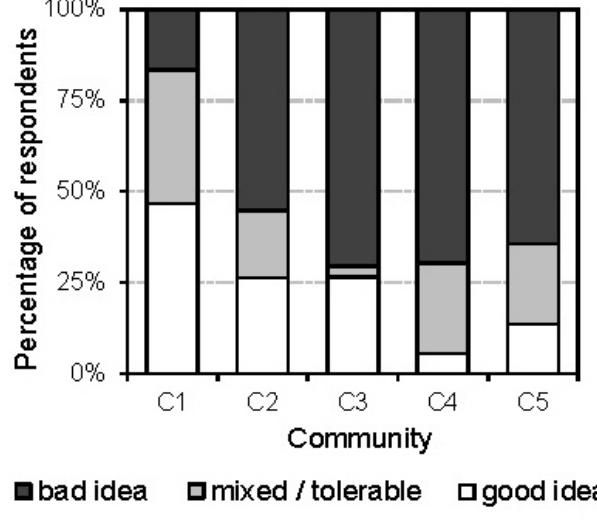
Fig. 6 . Community members’ perceptions about land subdivision and privatization. Respondents were asked whether they believed that future subdivision and privatization of land would be a good idea, a mixed or tolerable idea, or a bad idea. Perceptions varied significantly among communities ( χ ²[28, n = 247] = 65.7; p <